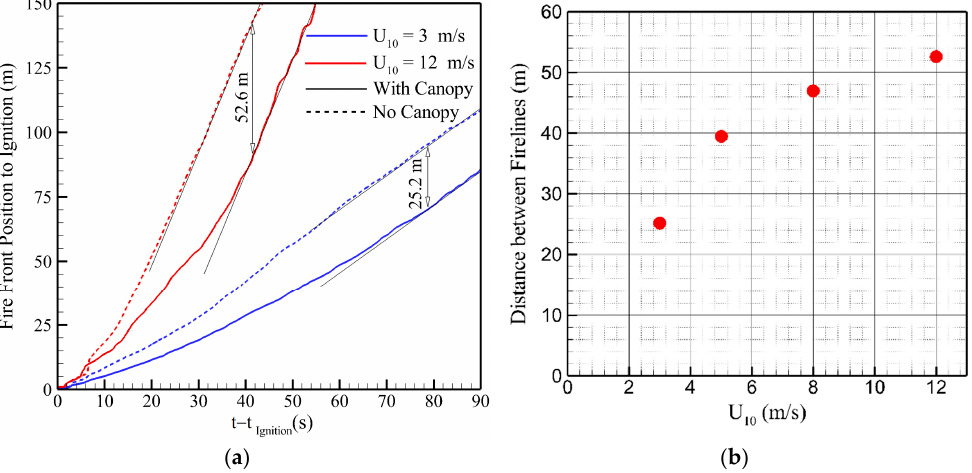
Figure 15. ( a ) Time evolution of the average position of the fire front at the grassland surface obtained for U 10 = 3 m/s and 12 m/s in the case of fire spread downstream of a canopy, compared to the case of fire spread obtained for the same simulation conditions but without a canopy. ( b ) Distance between the fire position obtained at steady state with and without the presence of a canopy upstream the grassland for all cases except the U 10 = 1 m/s case.